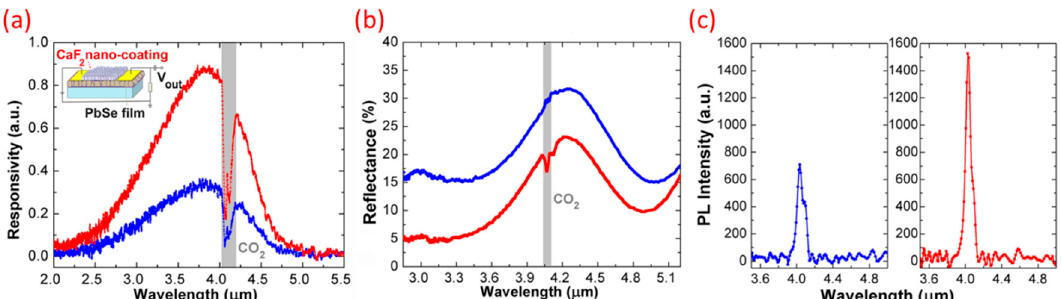
Figure 11. The morphological and optical properties of CaF 2 nanostructure-coated PbSe polycrystalline film; ( a ) high-resolution field emission scanning electron microcopy (FESEM) image of CaF 2 nanostructure arrays; ( b ) cross-sectional FESEM image; and ( c ) magnified view of PbSe polycrystalline film with CaF 2 nanostructured coating; ( d ) schematics of light bending effect and gradient refractive index profile of CaF 2 nanostructured coating. Reprinted with permission from [83]. Copyright AIP 2014.